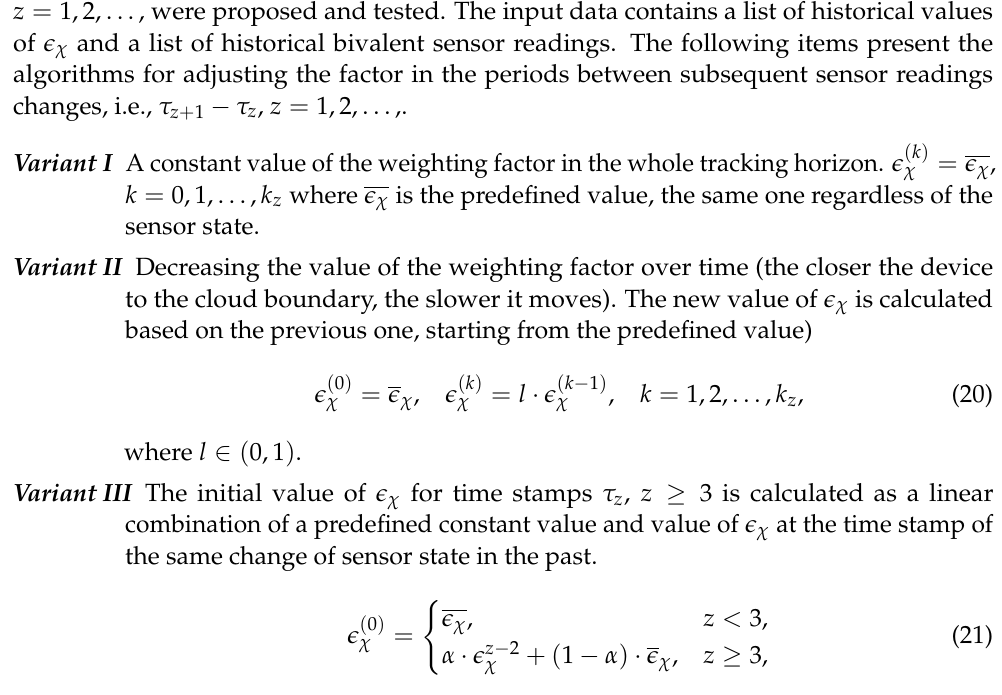
Figure 6. Recommended directions of D P ( b ) convex; ( c )